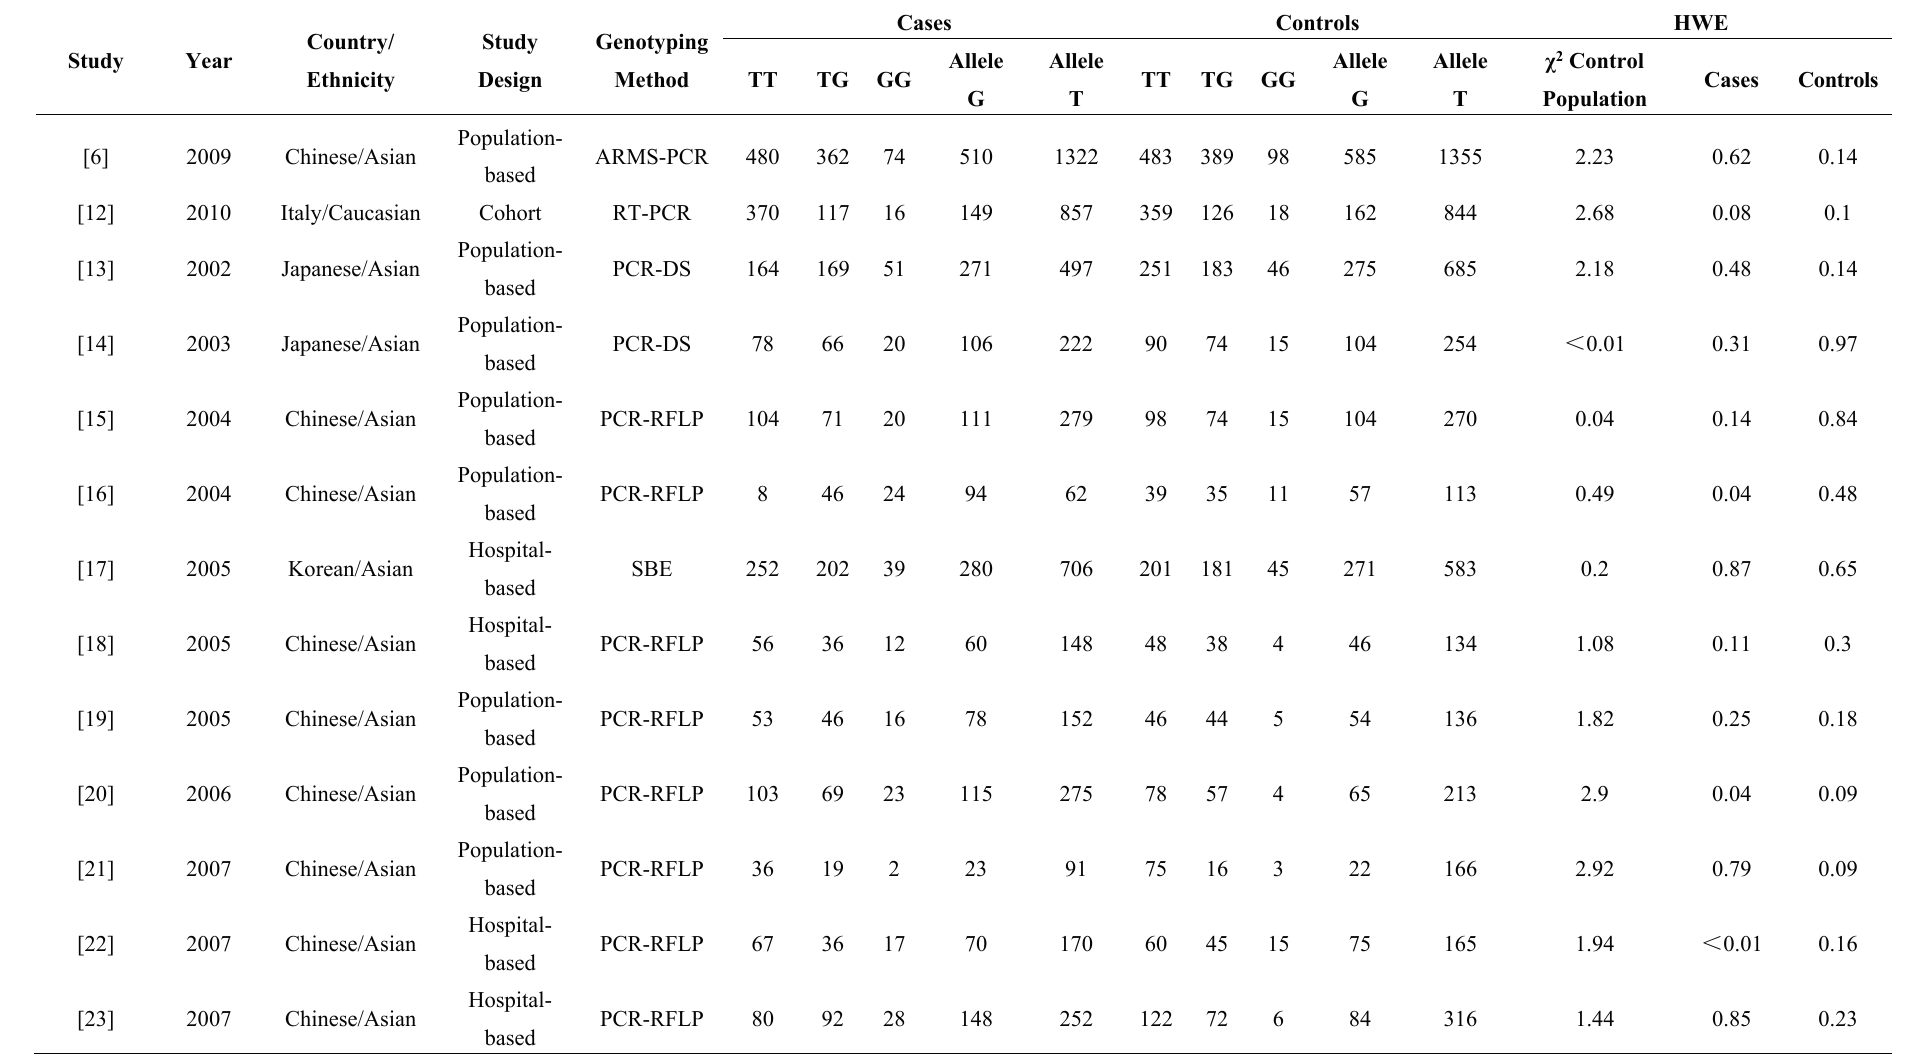
Table 1. Characteristics of studies included for investigation of associations between SNPs +45T>G and type 2 diabetes risk.